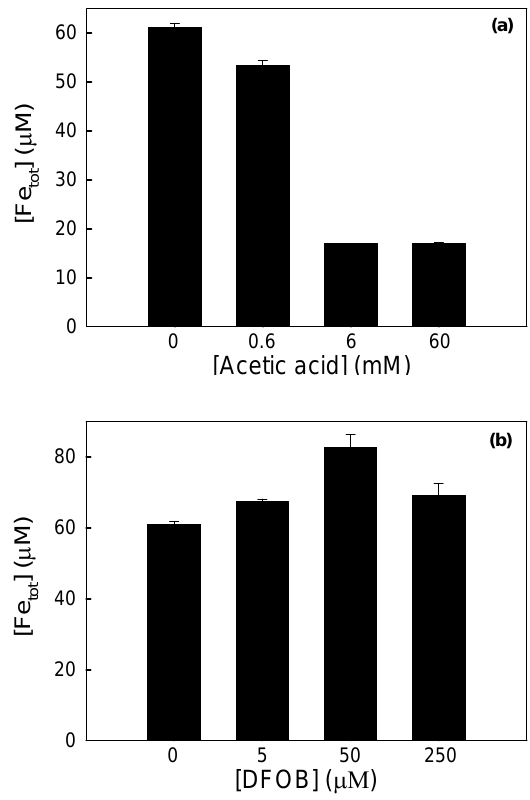
Fig. 4. Total dissolved iron generation from goethite in the presence of various concentrations of (a) acetic acid and (b) DFOB. Experimental conditions: [ α -FeOOH] i = 0.2 g L -1 , and pH i = 3.00 ± 0.05.